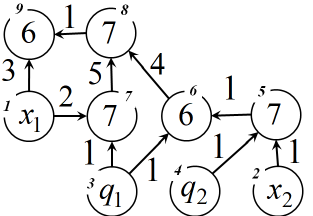
Figure 2. The network operator graph of the mathematical